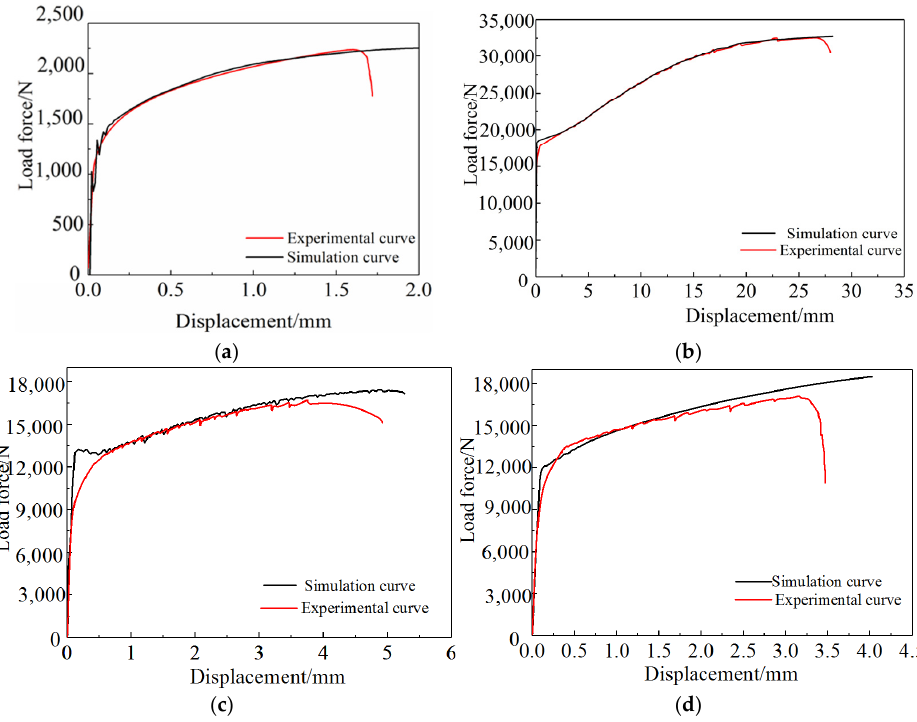
Figure 5. Comparison of load force-displacement curves between experimental and simulated ten- sile samples. ( a ) Shear sample. ( b ) Circular arc tensile sample. ( c ) Arc-shaped notched tension sample R = 8 mm. ( d ) V-shaped notched tensile sample α = 90°.